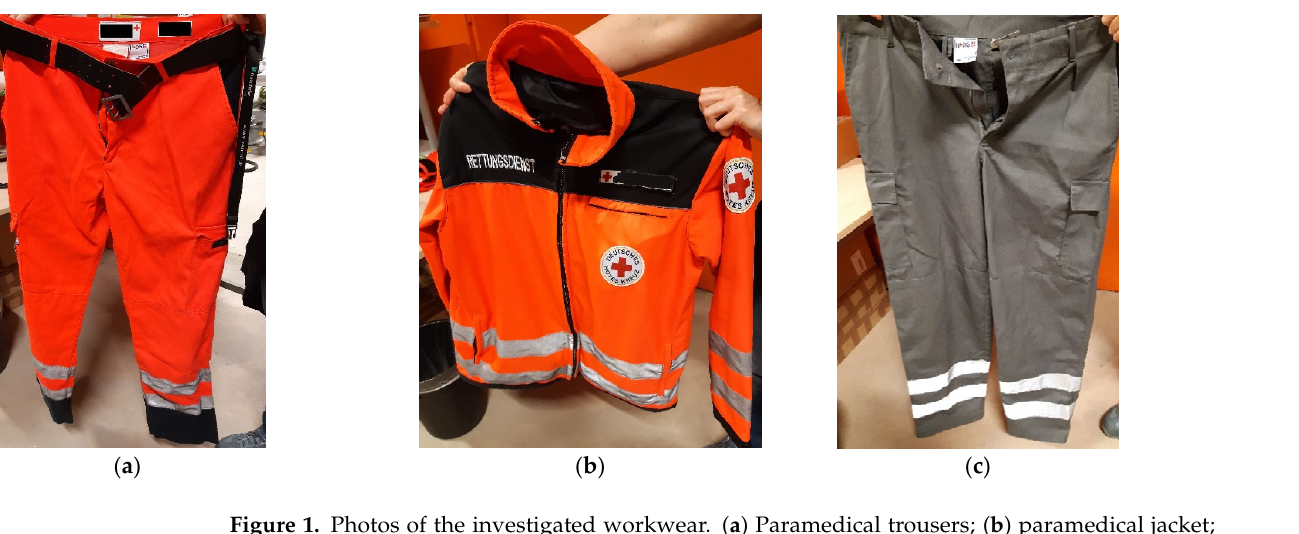
Figure 2. ( a ) Schematic of the used drawer system equipped with a dual ‐ energy line detector and an X ‐ ray source (adapted from [26], licensed under CC BY 4.0). ( b ) Example of workwear placed in the drawer system and loaded with a cutter, a mobile phone, and other foreign items.